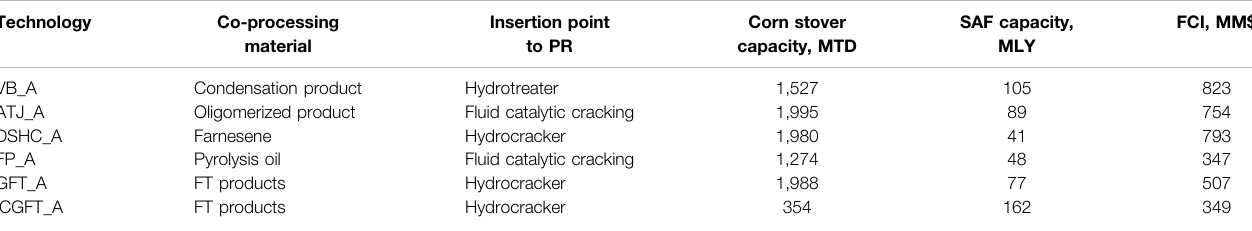
TABLE 2 | SAF capacities, feedstock capacities, and scaled FCI; corn stover was the feedstock.